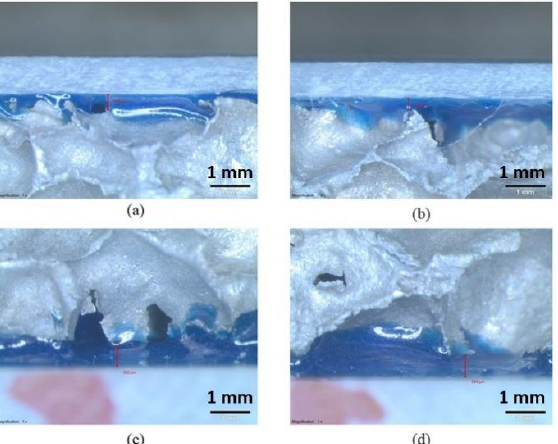
Figure 7. High-density foam core (HDFC) face sheet/core interface: ( a ) and ( b ) show the top face sheet/core interface at two different locations; ( c ) and ( d ) show the bottom face sheet/core interface at two different locations.